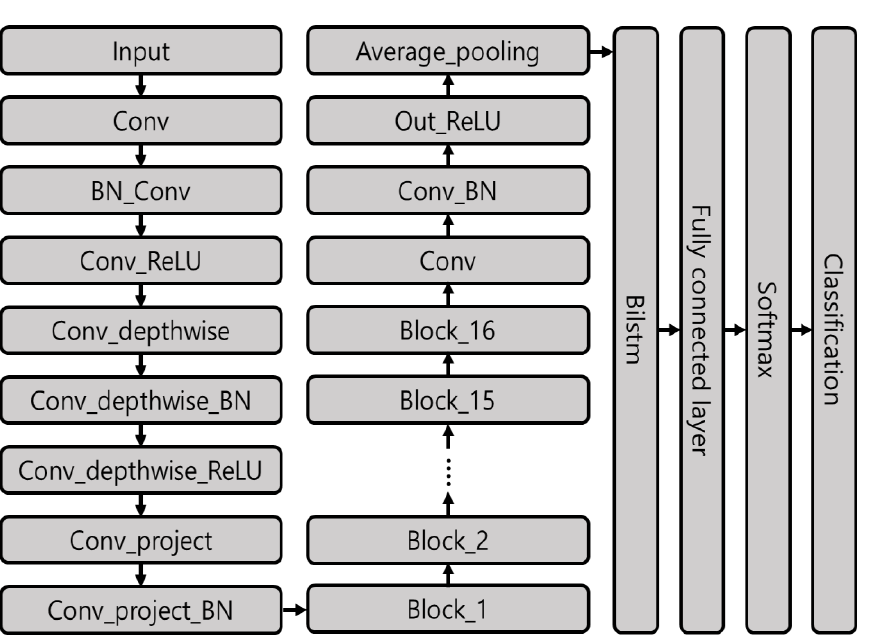
Figure 8. Block included in MobileNetV2. The block performs the resize process and convolution of the input data. Normalization is performed in blocks so that algorithms can process data. Mo- bileNetv2 has 16 interconnected blocks. Because sequence data processing is difficult with general neural networks, a special recurrent neural network was used for BiLSTM. Each LSTM layer has three gates that transmit or control data and can learn by considering the gradient decay problem. LSTM obtains the information of all the cells over time. However, data cannot be learned after